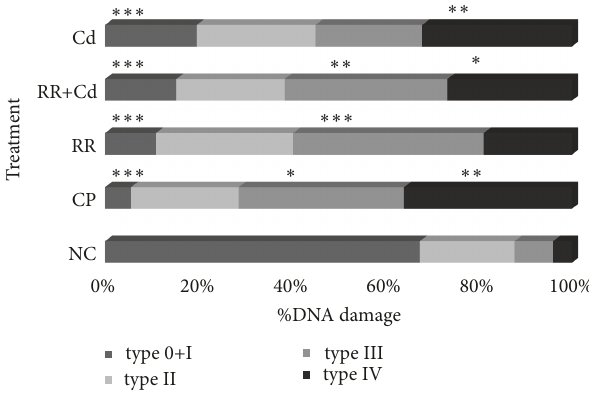
Figure 5: Percentage of DNA damage in peripheral blood ery- throcytes of Cnesterodon decemmaculatus exposed to different treatments, based on five types of nucleoids (0+I; II; III and IV). Treatments: NC (negative control, MHW); CP (positive control, 5 mg cyclophosphamide/L); RR (surface water of the Reconquista River); RR+Cd (surface water of the Reconquista River with 2 mg Cd/L); Cd (2 mg Cd/L). Significant differences with respect to control values at ∗ p < 0.05, ∗∗ p < 0.01, and ∗∗∗ p < 0.001.Number of individuals analyzed in each treatment: